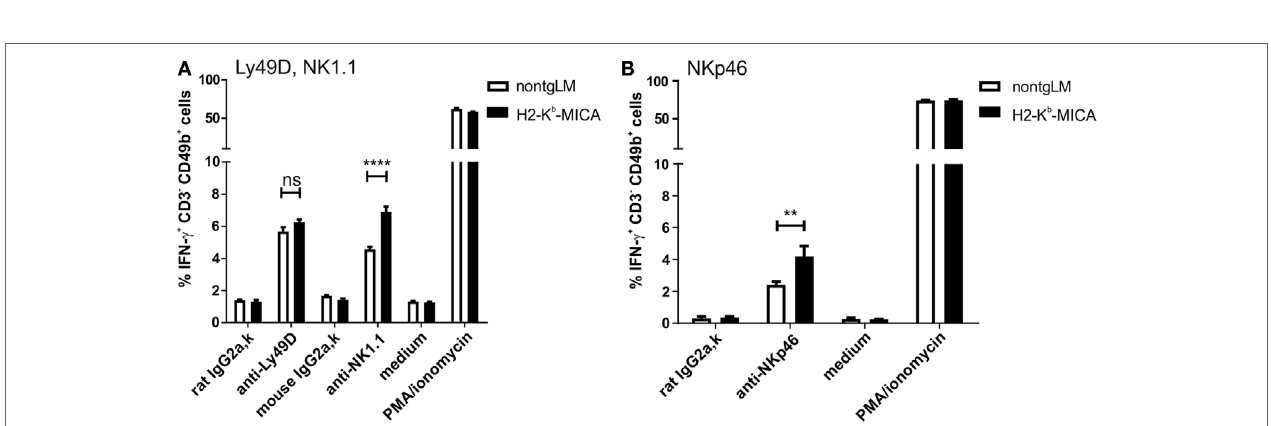
FigUre 6 | Increased frequencies of IFN γ -producing NK cells in H2-K b -MICA mice upon triggering NK1.1 and NKp46. (a,B) Freshly isolated splenic NK cells from H2-K b -MICA mice or non-transgenic littermates (non-tgLM) were stimulated for 4 h with plate-bound (a) anti-Ly49D or anti-NK1.1 or (B) anti-NKp46, subsequently frequencies of IFN γ -producing NK cells (CD3 − CD49b + ) determined by flow cytometric analysis of permeabilized cells. Stimulations with isotype controls (IgG2a), medium, or PMA/ionomycin were included as controls. Data represent means of triplicates with SDs. P values were determined using two-way ANOVA with a Sidak posttest for multiple comparisons.